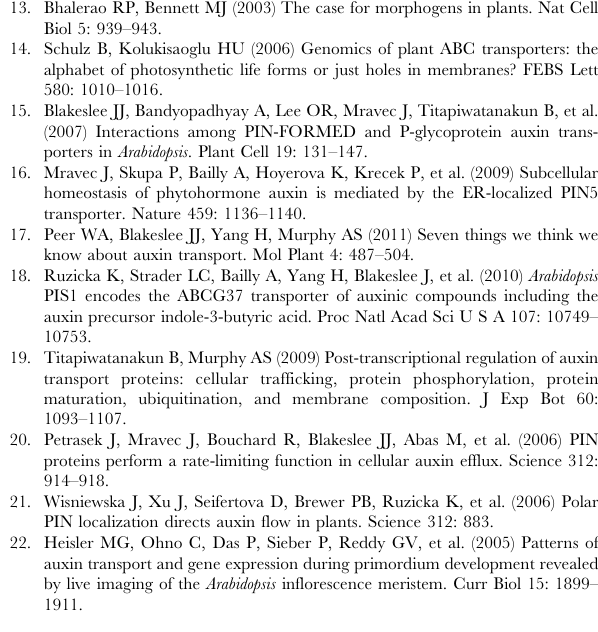
Figure S5 AtAUCSIA-1 interacts in vitro with 1-amino- cyclopropane-1-carboxylate oxidase (ACO2; At1g62380 ). (A) ACO2 protein was identified by yeast two-hybrid assay. Six independent clones, corresponding to portions of ACO2 protein, interacted with the entire AtAUCSIA-1 protein (green box) defining a common overlapping domain of 148 aminoacids (red box). (B) The GST-AUCSIA-1 fusion protein interacts with (His) 6 - ACO2 in an in vitro binding assay. (His) 6 -ACO2 protein, either in denatured (den (His) 6 -ACO2) or native form, was bound to nickel- nitrilotriacetic acid magnetic beads and then incubated in the presence of purified GST-AUCSIA-1. The protein fractions bound to magnetic beads were eluted, separated by SDS-PAGE, and detected by Western blot using either anti-GST or anti-His antibodies. (His) 6 -ACO2 coated beads pulled down GST-AUC- SIA-1. Beads alone were used as negative control to test non specific interactions. Purified (His) 6 -ACO2 and GST-AUCSIA-1 proteins were used as protein markers in SDS-PAGE.